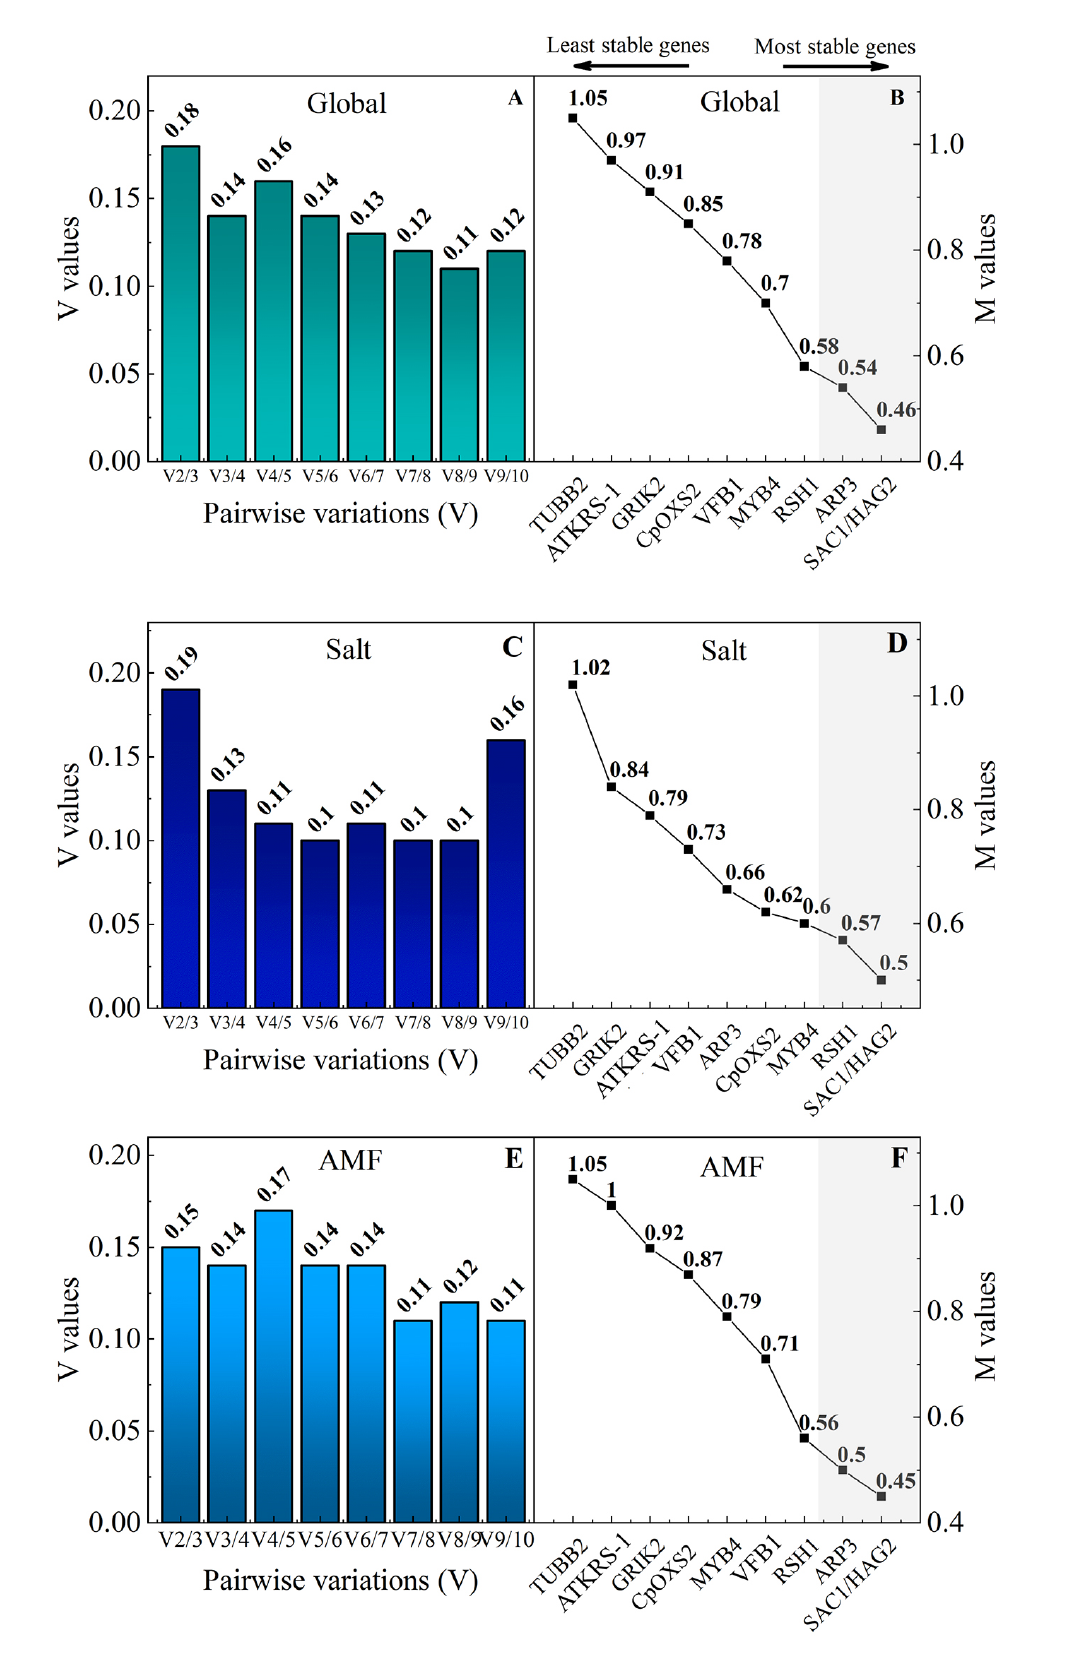
Figure 2 ‒ Analysis of reference genes. A, C and E represent the pairwise variation analysis between normalization factors NFn and NFn+1, indicating the optimal number of reference genes (RGs) required for reliable normalization in root tissues of Cenostigma pyramidale under salt stress and associated with arbuscular mycorrhizal fungi (AMF) for global, salt and AMF assays, respectively. B, D, and F - average expression stability (M value) of ten candidate reference genes (CRGs) for global, salt, and AMF assays,